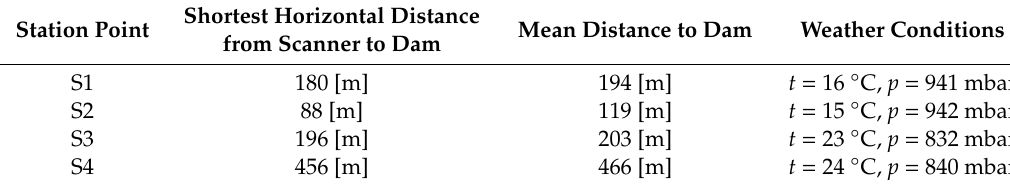
Table 2. Overview of scanning configurations and atmospheric conditions.